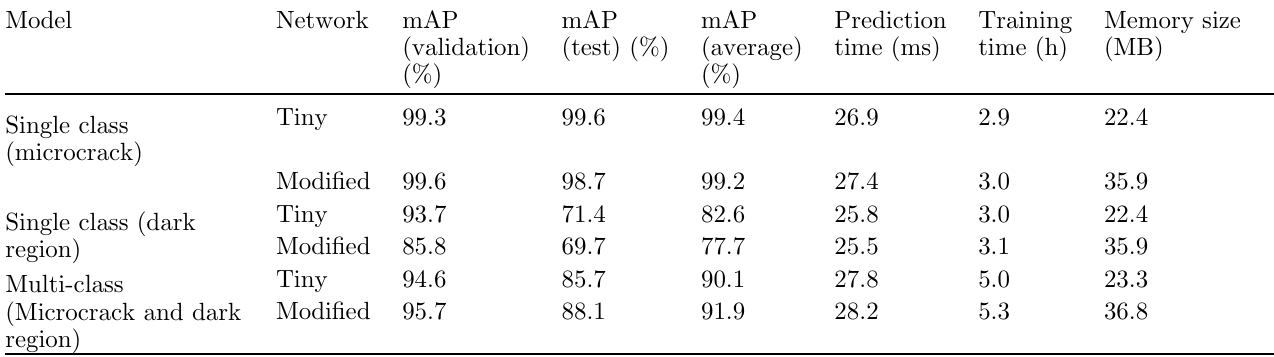
Table 4. Performance of the Tiny-YOLOv4 comparing original and modi fi ed networks.